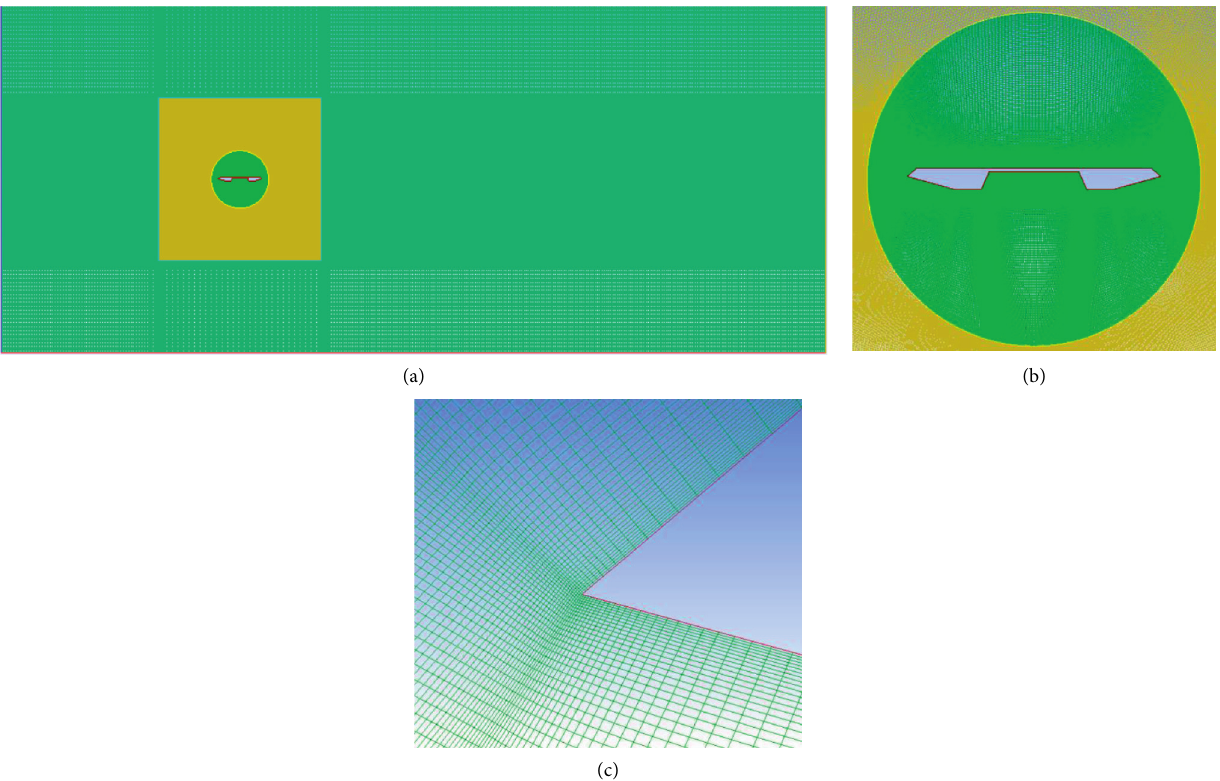
Figure 3: Grid of the deck section of the Second Jiaojiang Bridge. (a) Overall grid diagram. (b) Internal rigid grid region. (c) Front edge wall grid amplification.